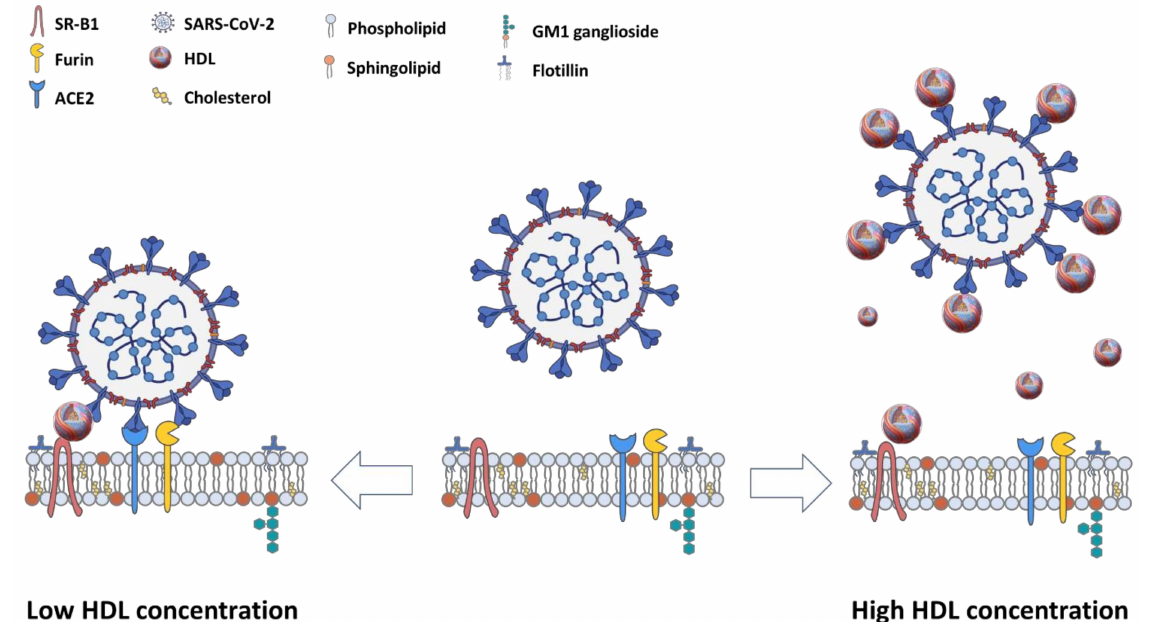
Figure 3. Hypothetical HDL concentration-dependent effects on SARS-CoV-2 infection. In the absence of HDL ( center ), SARS-CoV-2 binds to ACE2 via the virus’s spike protein, but without the participation of the HDL receptor, SR-B1. When HDL is present at a low particle concentration ( left ), HDL particles bind to SARS-CoV-2 via the virus’s spike protein but leave other molecules of spike protein accessible for binding to ACE2 on cells, allowing for bridging of ACE2 and SR-B1 [26]. This may allow SR-B1 to modify the local membrane environment of the ACE2 receptor in a way that favors viral entry, although other mechanisms are possible. When HDL is present at high particle concentrations ( right ), virus particles may bind to multiple HDL particles. This may result in HDL competing with ACE2 for binding to viral spike proteins, preventing SARS-CoV-2 from entry into host cells. Alternatively, the binding of the complex of one virus particle with multiple HDL particles to SR-B1 may result in alterations in the membrane lipid composition that disrupt viral entry into cells. Another possibility is that at higher HDL particle concentrations, HDL that is not bound to SARS-CoV-2 particles may compete with the HDL bound to SARS-CoV-2 for binding to SR-B1, preventing bridging of SR-B1 and the ACE2 receptor. SARS-CoV-2 virus picture was captured from